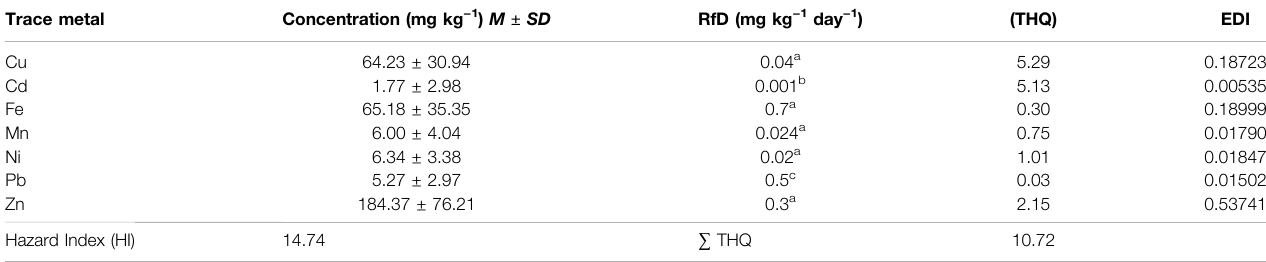
TABLE 4 | Average concentration of trace metals, reference dose (RfD), non-carcinogenic health risk (THQ), and hazard risk (HI) in the edible tissue of C. bellicosus from the Navachiste coastal lagoon system in Mexico. Trace metal